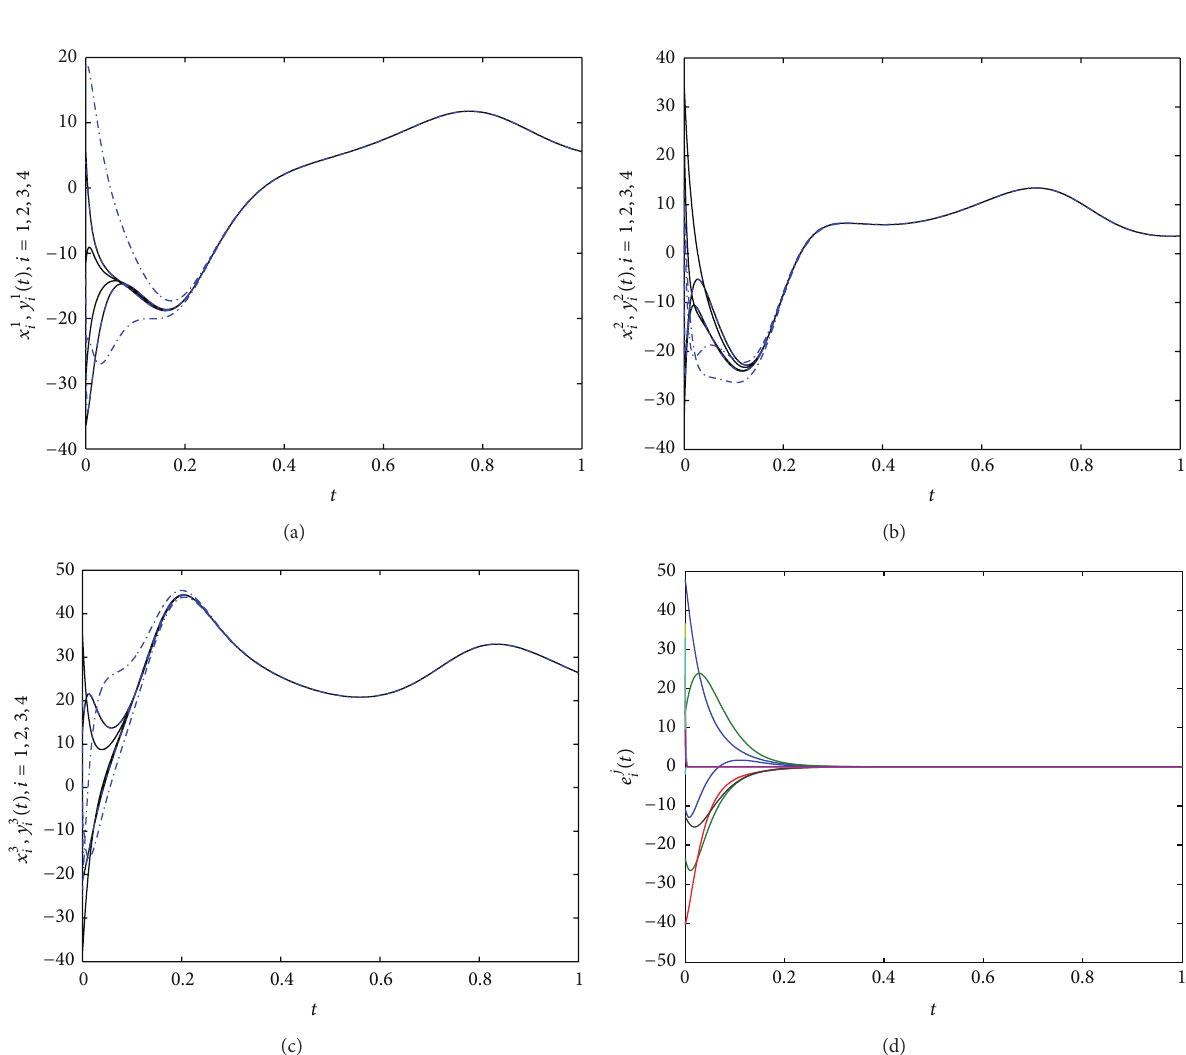
Figure 1: The attractor of the Lorenz system.